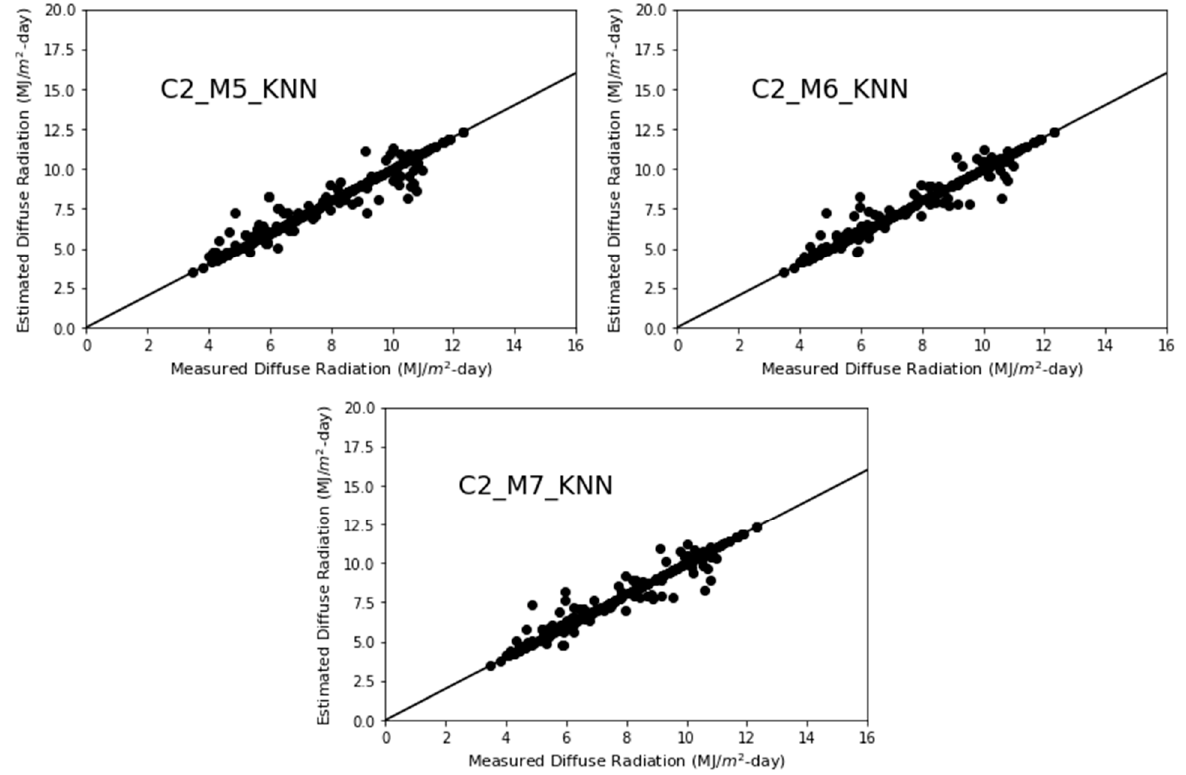
Figure 4. Plot depicting predicted and measured DSR from KNN ML models (Category 2).